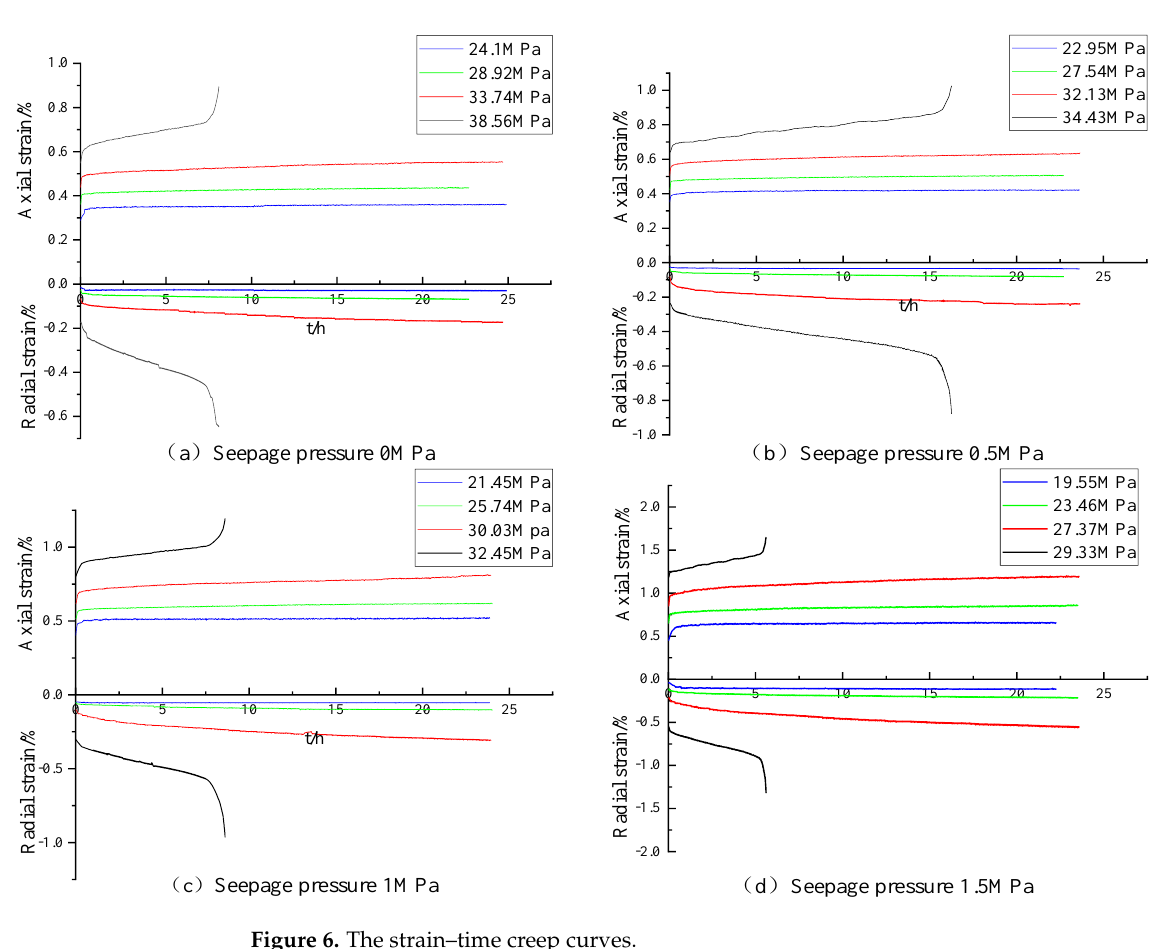
Figure 6. The strain–time creep curves. The creep deformation characteristics of red-bed soft rocks are roughly similar, but the instantaneous deformation and creep deformation increase with an increase in seepage pressure. Under the same seepage pressure, the instantaneous deformation is greater than the creep deformation when the stress is low, whereas the opposite is true when the stress is high. The main reason is that the higher the seepage pressure, the stronger the